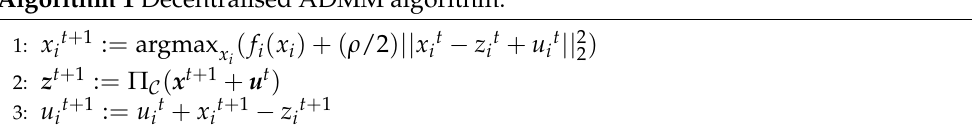
Algorithm 1 Decentralised ADMM algorithm.